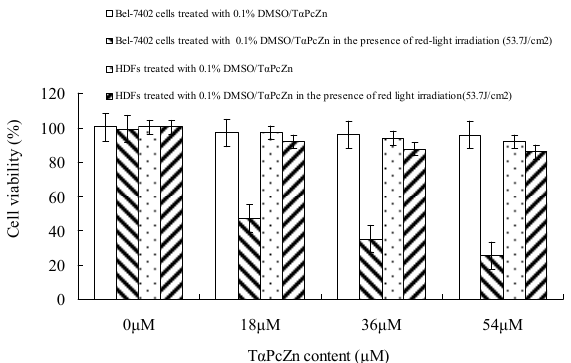
Figure 3. Effect of T α PcZn-PDT on the proliferation of Bel-7402 cells and HDFs. Proliferation of Bel-7402 cells and HDFs analyzed by MTT assay. Bel-7402 cells and HDFs were treated with the different concentrations of T α PcZn in the presence of red-light irradiation (53.7 J/cm 2 ). Cell viability was detected by MTT assay. P < 0.01 versus the control value (cells treated with 0.1%